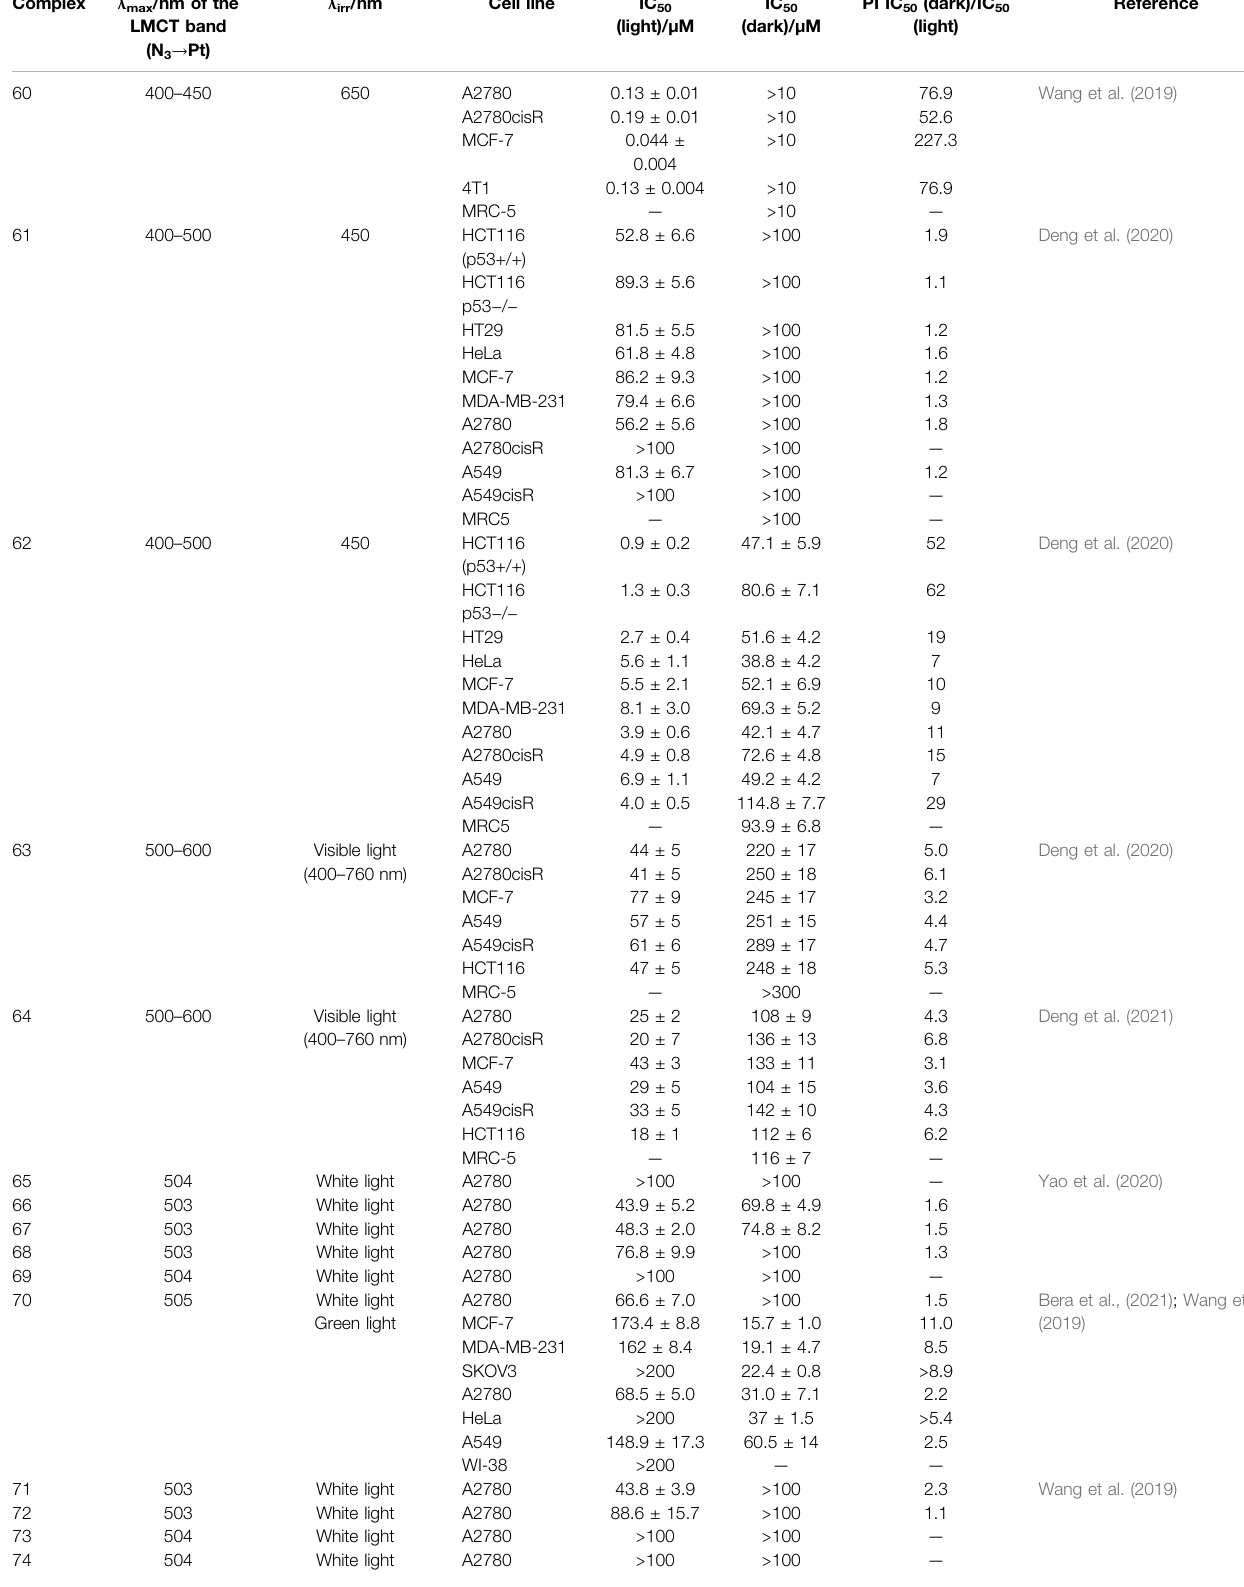
TABLE 7 | IC 50 values of complexes 60 — 74 to various cancer cell lines. Complex λ max /nm of the LMCT band